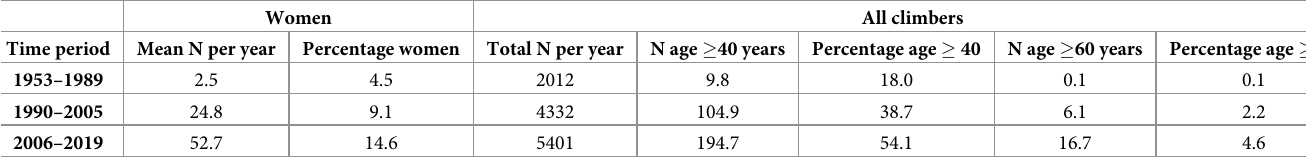
Table 1. Temporal trends in demographic makeup of